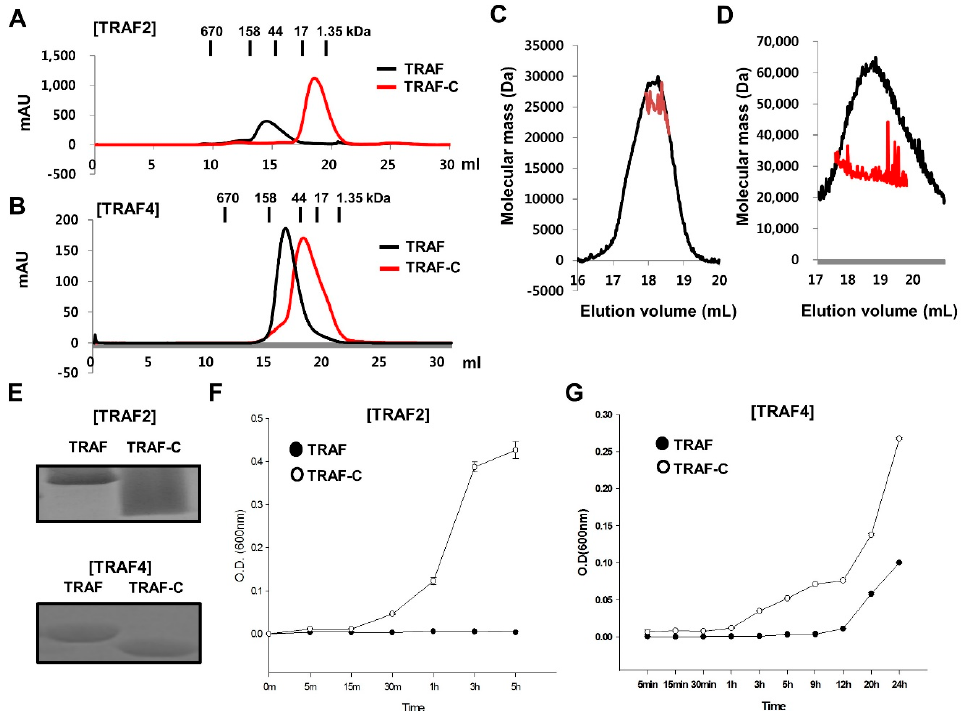
Figure 4. Critical effect of TRAF-N on trimer formation and stability of the TRAF domain. ( A , B ) Comparison of size-exclusion chromatography profile between the TRAF domain and TRAF-C